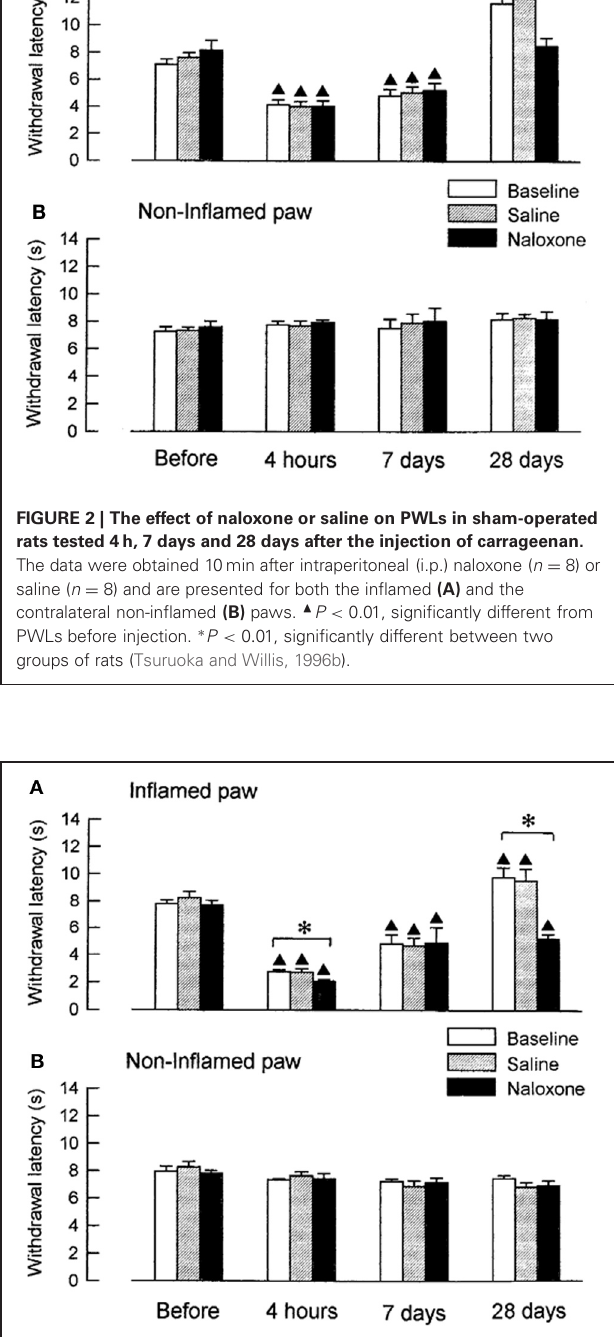
FIGURE 3 | The effect of naloxone or saline on PWLs in LC-lesioned rats tested 4h, 7 days and 28 days after the injection of carrageenan. The data were obtained 10min after i.p. naloxone ( n = 6) or saline ( n = 6) and are presented for both the inflamed (A) and the contralateral non-inflamed (B) paws. (cid:2) P < 0.01, significantly different from PWLs before injection. ∗ P < 0 . 01, significantly different between two groups of rats (Tsuruoka and Willis,